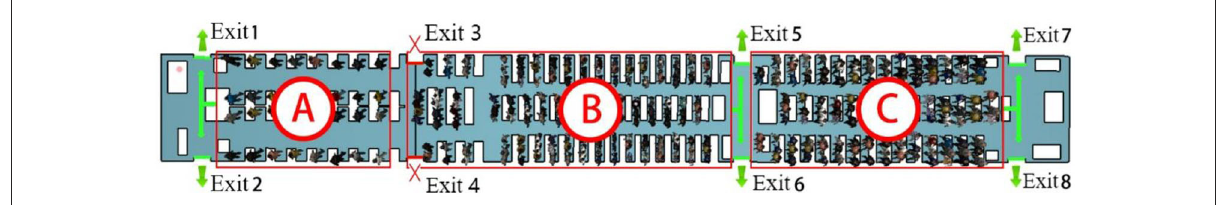
FIGURE21 Schematic diagram of the evacuation optimization scheme for adding guidance.